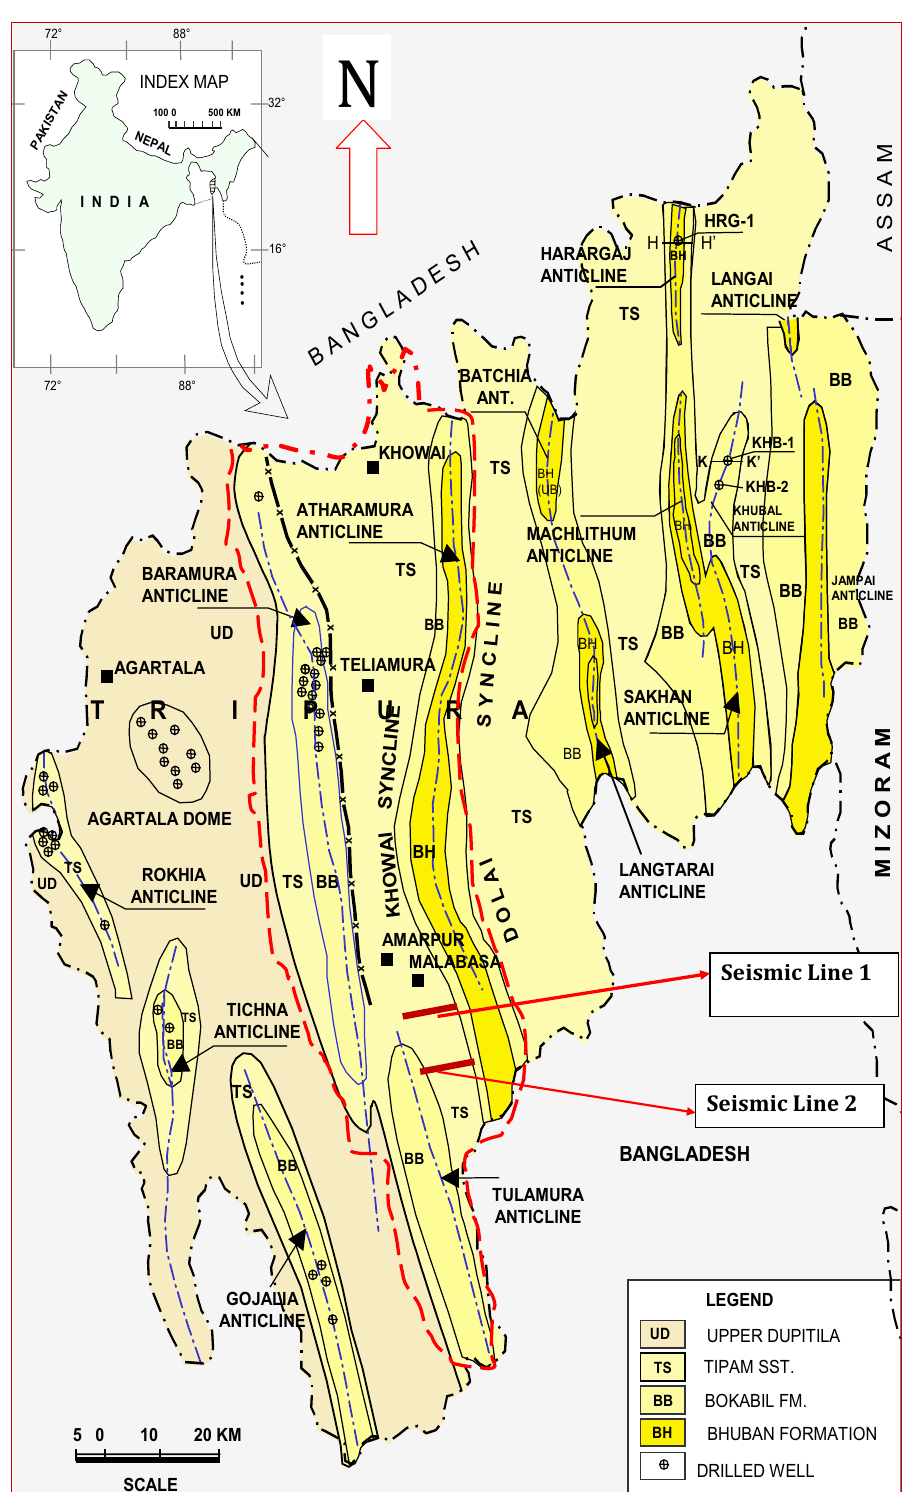
Fig. 2 Anticlines and synclines in and round Atharamura, Bara- mur and Tulamura anticlines. Map depicts the structural posi- tion of the study area (Repro- duced with permission from Ganguly